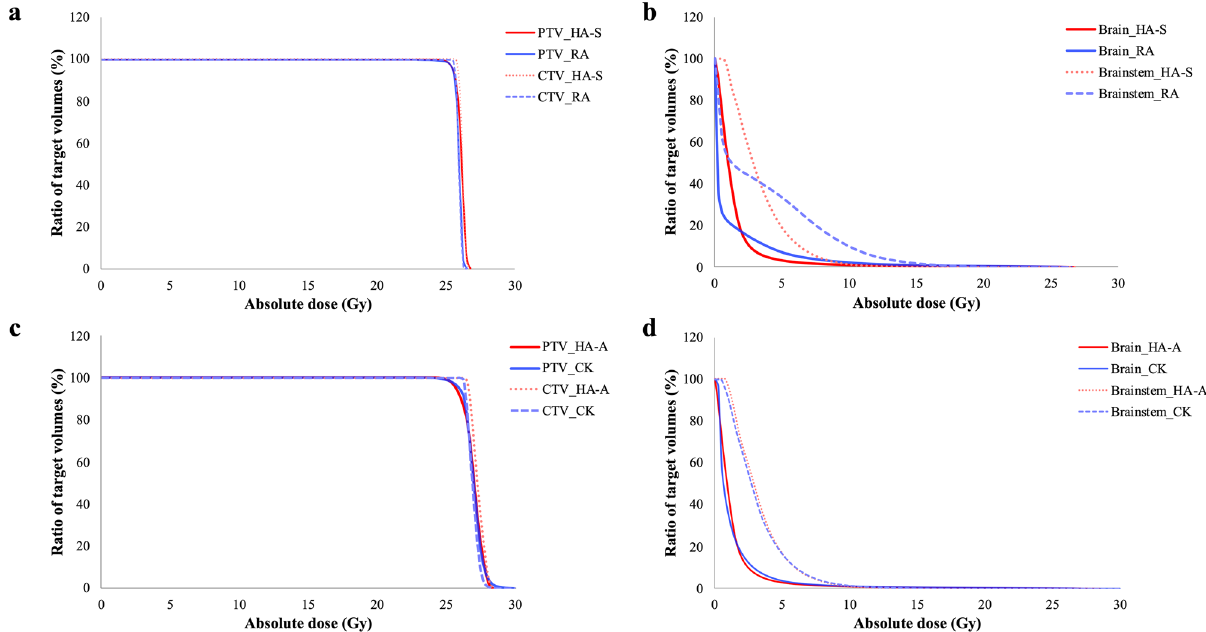
Figure 2. Dose-volume histograms for the applied HyperArc-SRS NTO, RapidArc, HyperArc-ALDO and CyberKnife plans. ( a ) Clinical target volumes (CTV) and planning target volumes (PTV) of the RapidArc and HyperArc-SRS NTO plans; ( b ) brain and brainstem of the RapidArc and HyperArc-SRS NTO plans; ( c ) CTV and PTV of the HyperArc-ALDO and CyberKnife plans; ( d ) brain and brainstem in HyperArc-ALDO and CyberKnife plans; X-axis, the percentage of the prescription dose; Y-axis, the volume percentage of the